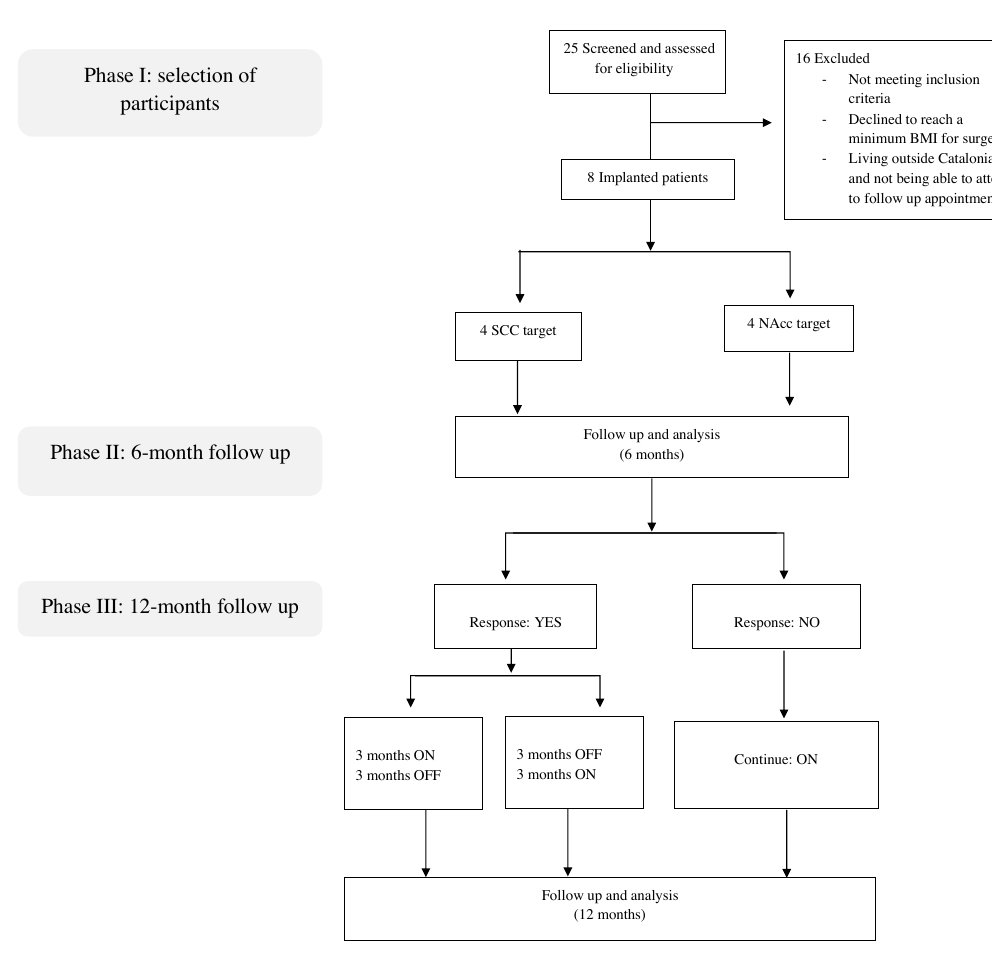
Figure 1. Participants’ selection and pathway for the randomized crossover controlled clinical trial. Here, results are presented including the follow-up analysis at 6 months.